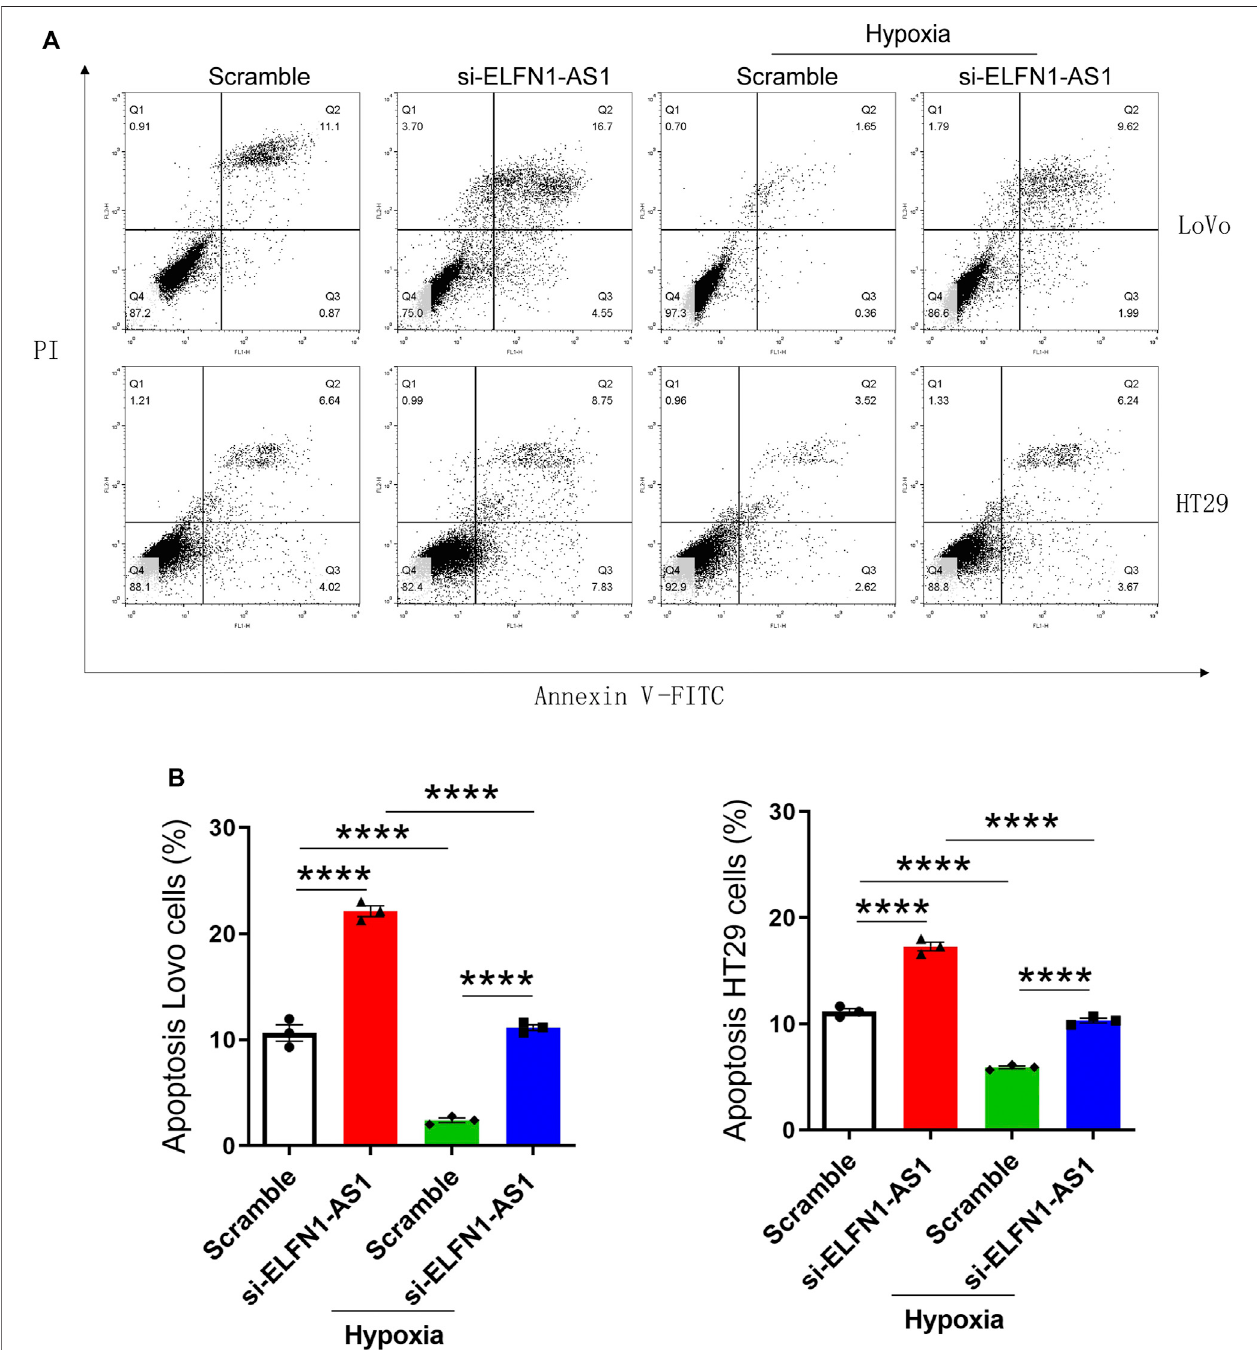
FIGURE 3 | ELFN1-AS1 blocks the inhibition of apoptosis induced by hypoxia in colon cancer cells. (A) Flow cytometry analysis was performed to detect the apoptosis in each group after the transfection for 24 h. (B) Percentage of apoptotic cells was analyzed using Flowjo software. Analysis was performed using one-way ANOVA with Bonferroni as a post hoc test. All data were representative of three independent experiments. **** p < 0.0001.